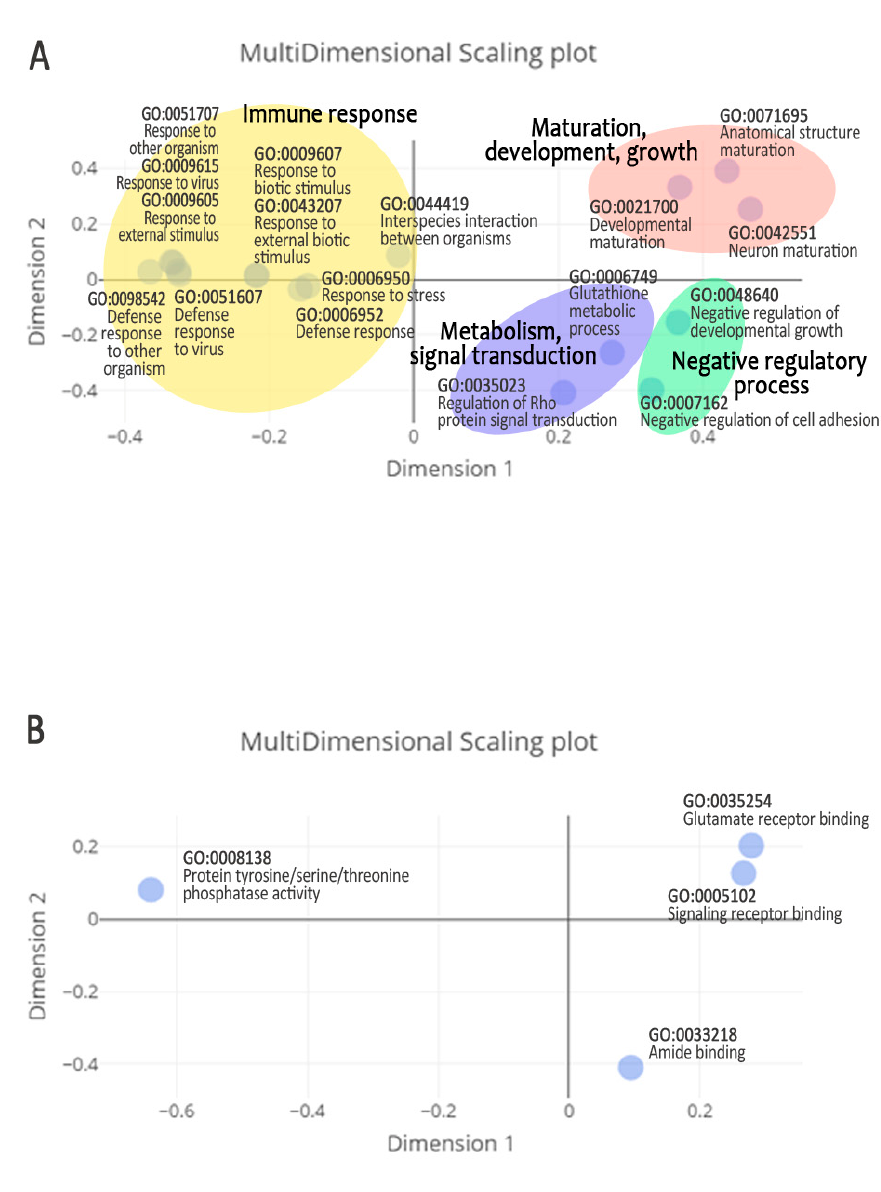
Figure 7. Multi-dimensional scaling (MDS) plots of Ensembl-derived GO terms associated with differences in FCR. Two data features are considered: biological process ( A ) and molecular function ( B ). The MDS plots provide a two-dimensional distance map of the Ensembl-derived GO terms associated with difference in FCR. The units of dimension 1 and dimension 2 are arbitrary. Each point represents a GO term ID with an associated name. Points that cluster nearer to one another in an MDS plot are more similar to one another. Colored areas are drawn to highlight the clusters, and thus the main biological processes associated with difference in FCR. Table 4. Entrez Gene-derived GO terms associated with differences in